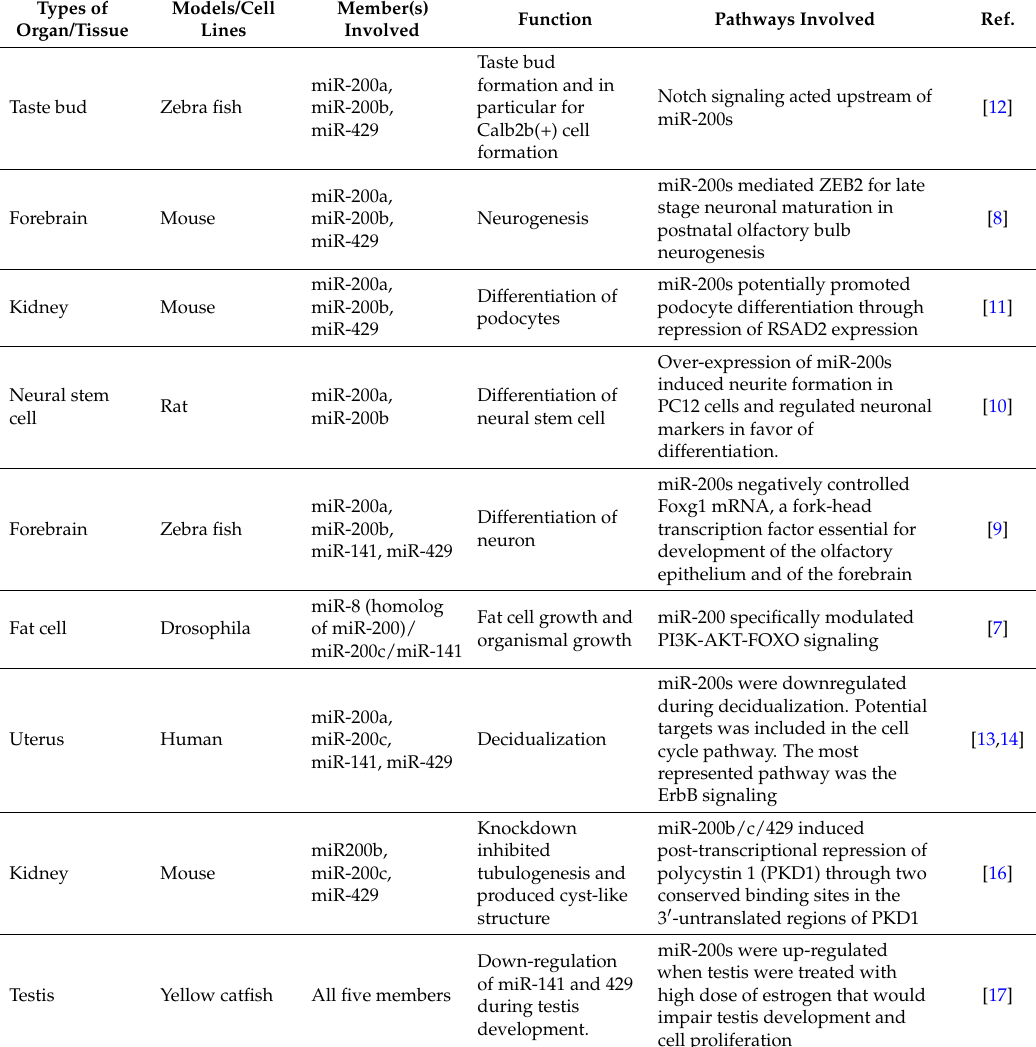
Table 1. Function of miR-200s in different organs and tissue